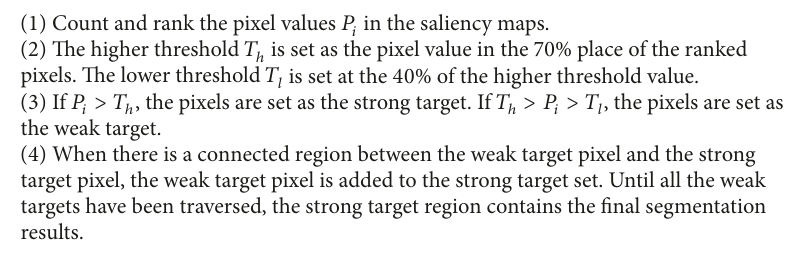
Algorithm 1: The main steps of the image segmentation